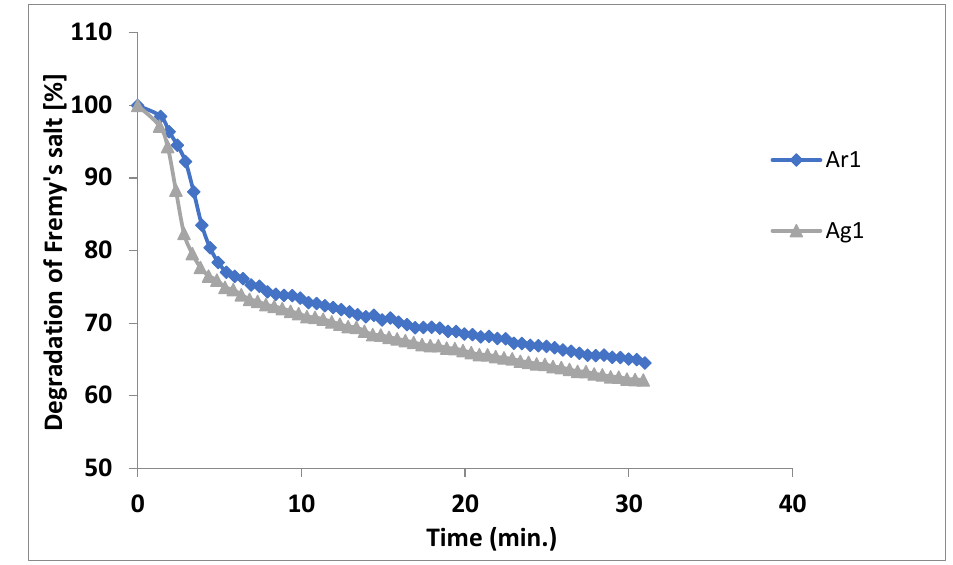
Figure 1. EPR measurements: Ag1 — A. genevensis extract, Ar1 — A. reptans extract.